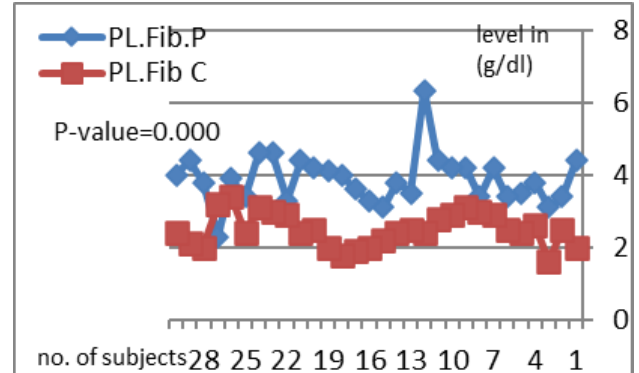
Figure (1) Plasma Fibrinogen concentrations for control & Patients'